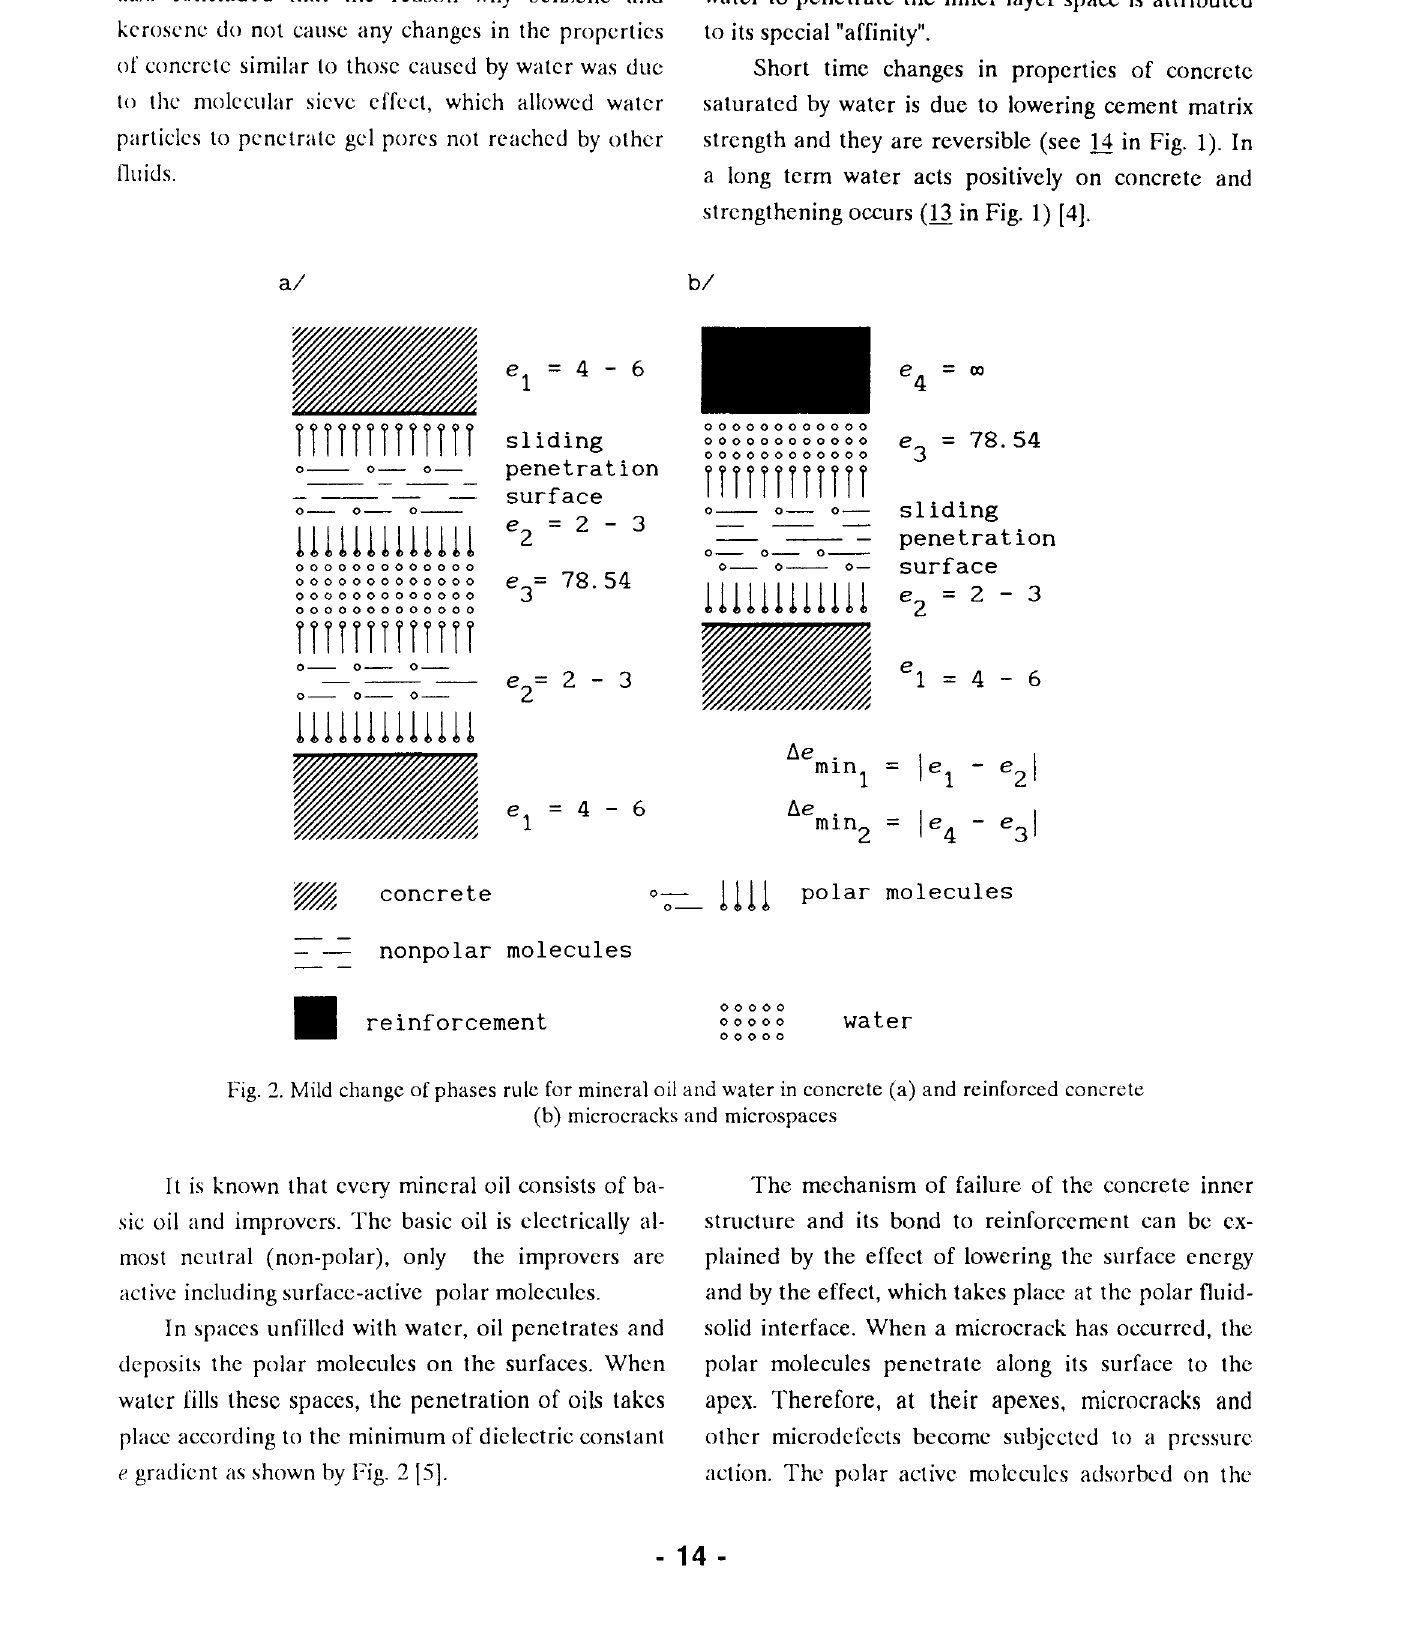
Fig. 2. Mild change of phases rule for mineral oil and water in concrete (a) and reinforced concrete (b) microcracks and